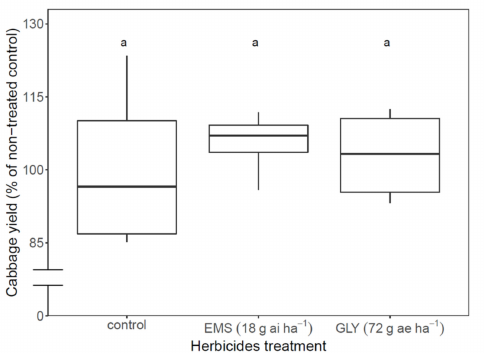
Figure 4. Cabbage sensitivity to the herbicides glyphosate (GLY) and ethametsulfuron-methyl (EMS). Herbicides were applied 21, 35, and 49 DAP at the doses of 72 g ae ha − 1 glyphosate and 18 g ai ha − 1 EMS. Means were compared using the Tukey HSD test ( p < 0.05); means that are indicated with the same letter do not show significant